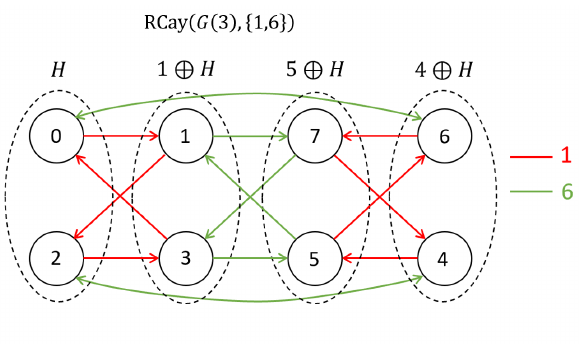
Figure 2. The right Cayley graph R-Cay ( G ( 3 ) , S 1 ) , where S 1 = { 1,6 } . The elements in G ( 3 ) are grouped by H -cosets, where H = { 0,2 } . The quotient right-Cayley graph R-Cay ( G ( 3 ) / H , S ∗ also be seen in this drawing when we consider each coset as a vertex.